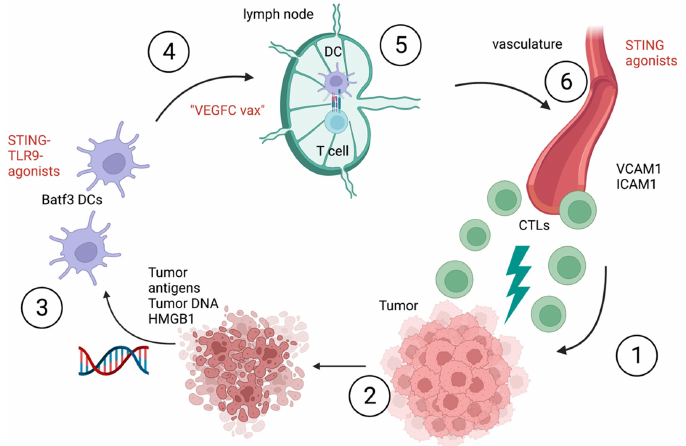
Figure 2. “Cancer–immunity cycle”. 1: CTL-mediated tumor killing; 2: tumor antigen release, release of HMGB1 and tumor-derived DNA; 3: tumor antigen uptake by Batf3 DCs, tumor-derived DNA